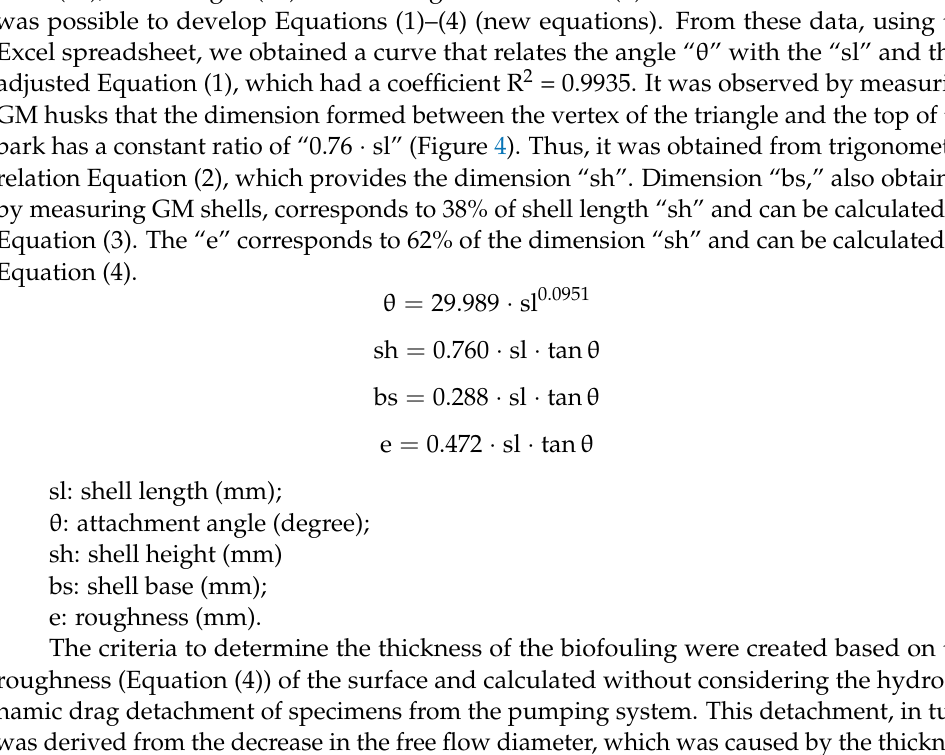
Figure 4. Description of how the golden mussel was measured, dimensions provided in mm.